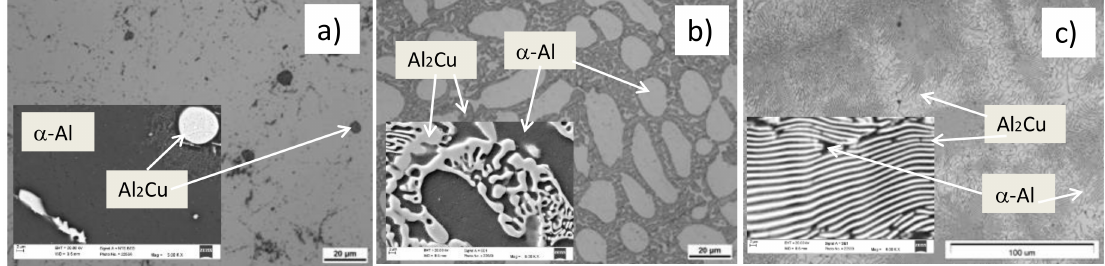
Figure 1. Microstructure of ( a ) Al–Cu alloy with 5 wt % of Cu (Al 5 Cu), ( b ) with 25 wt % of Cu (Al 25 Cu), and ( c ) with 33 wt % of Cu (Al 33 Cu) in initial state.